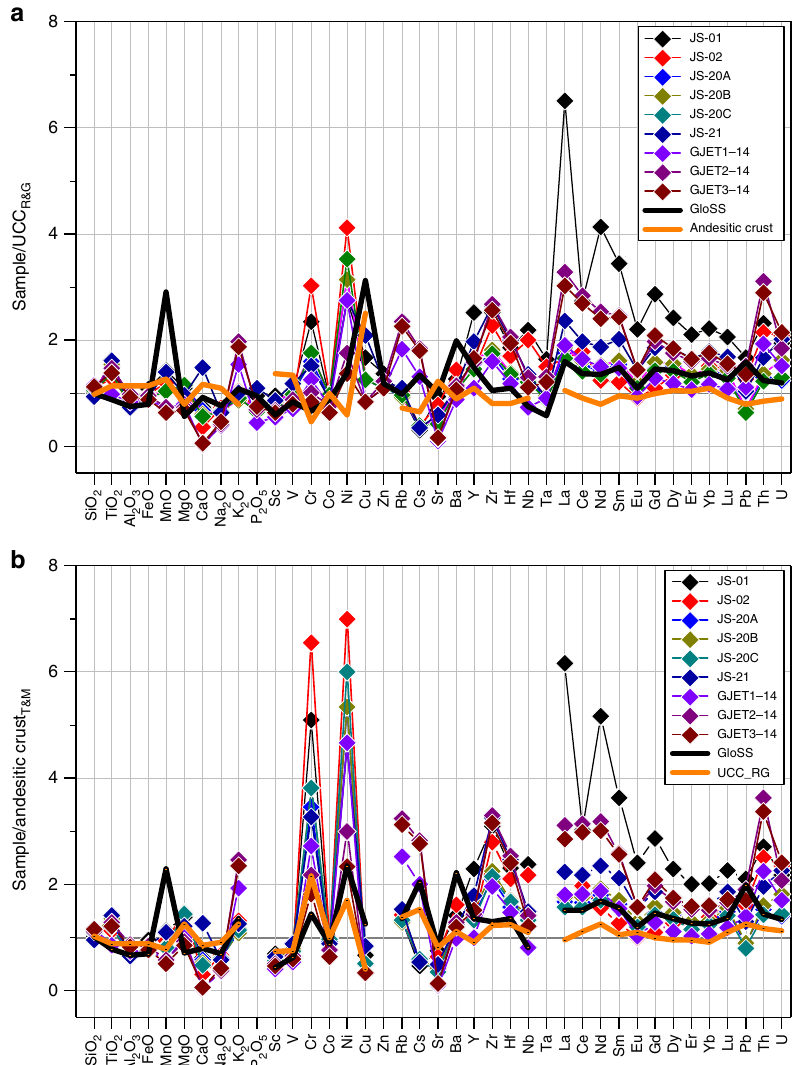
Fig. 9 Normalisation plots of Norwegian peridotite-bearing sandstone samples. Compositions are normalised to a the upper continental crust (UCC) 17 and b average andesitic crust 5 . The composition of the global subducting sediment (GloSS) 41 is shown for comparison. The distinct enrichment in Ni and Cr of sediment samples is complementary to their relatively low concentrations in andesite. The different Cr/Ni in UCC and GloSS in b may suggest preferential Ni particulate transport into the oceans 46 . The composition of sediment samples is listed in Supplementary Table